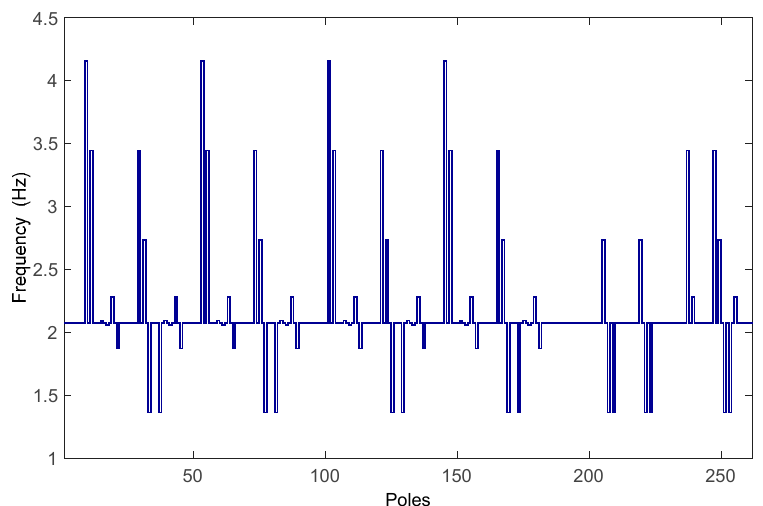
Figure 14. Pole spectrum of the reduced nonlinear transfer function for the case study of the test power system 3SM-9BUSES.